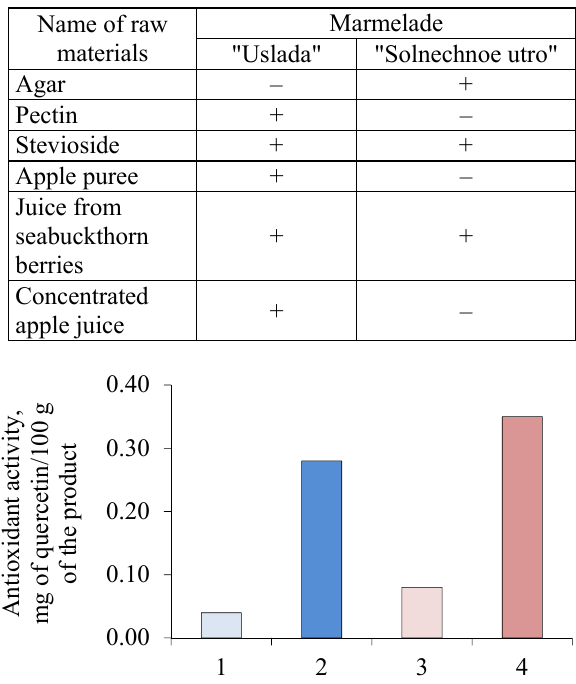
Fig. 9. Change in antioxidant activity in the marmalade samples: (1) agar-based marmalade (control); (2) agar-based marmalade "Solnechnoe utro"; (3) pectin-based marmalade (control); (4) pectin-based marmalade "Uslada".